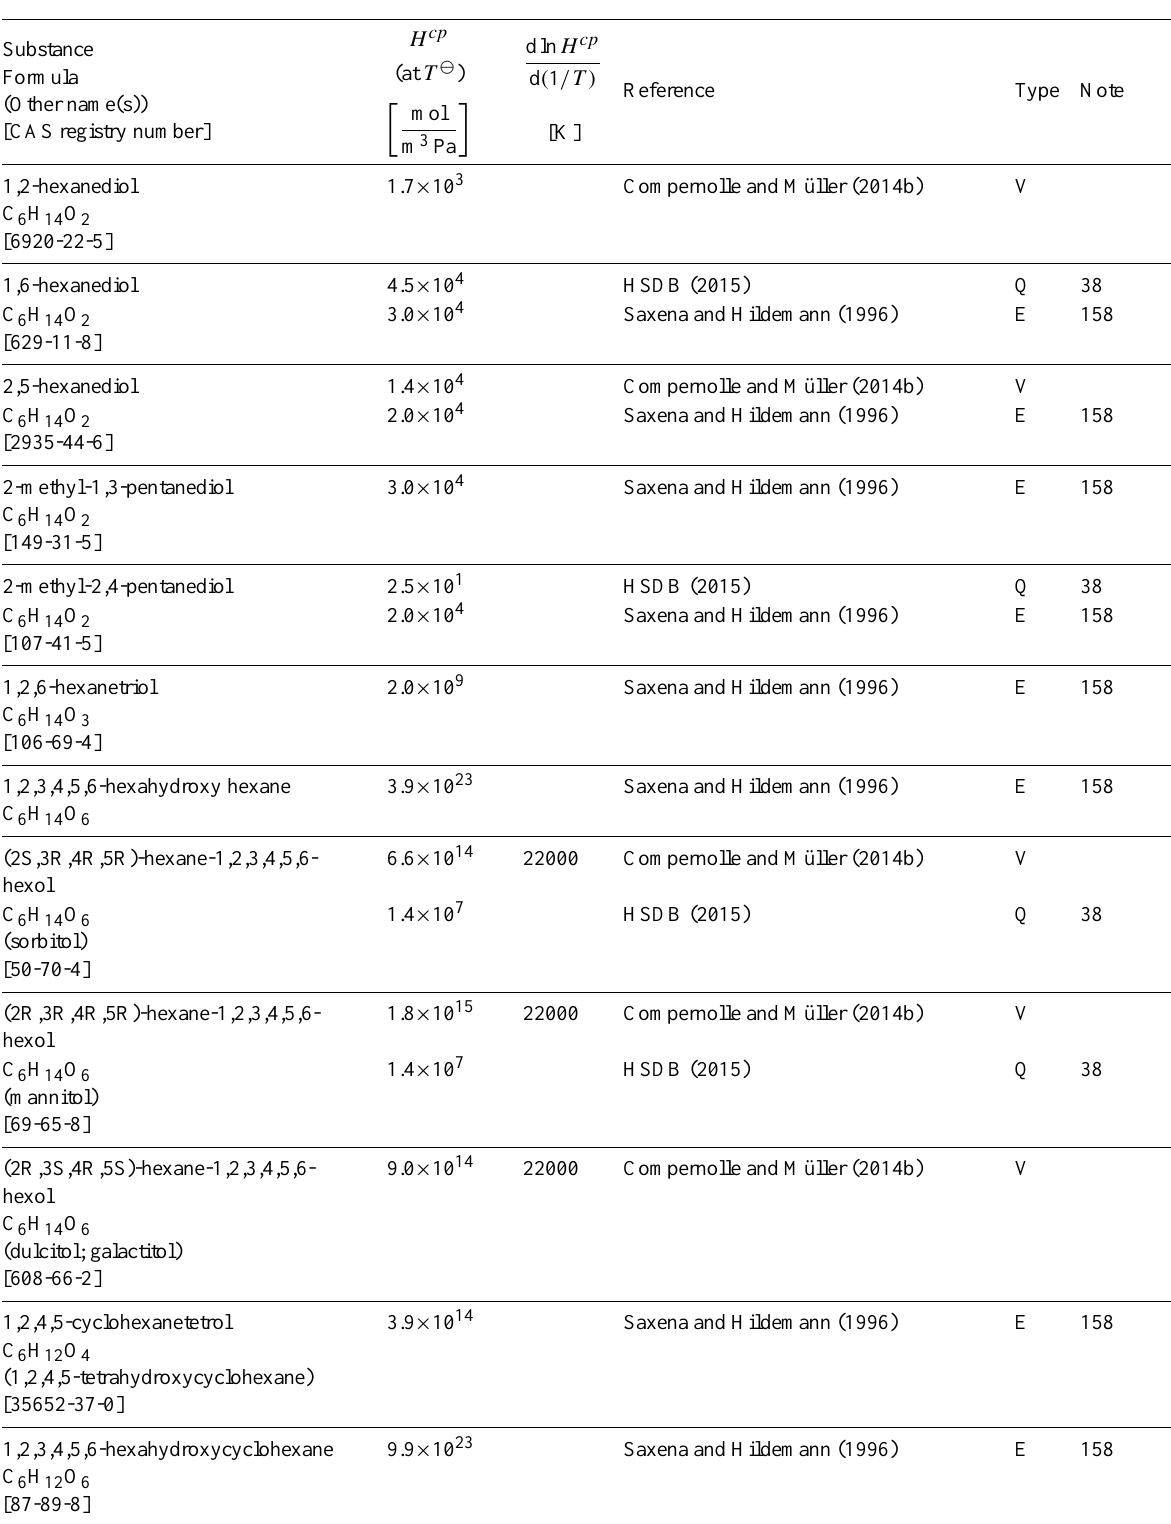
Table 6: Henry’s law constants for water as solvent